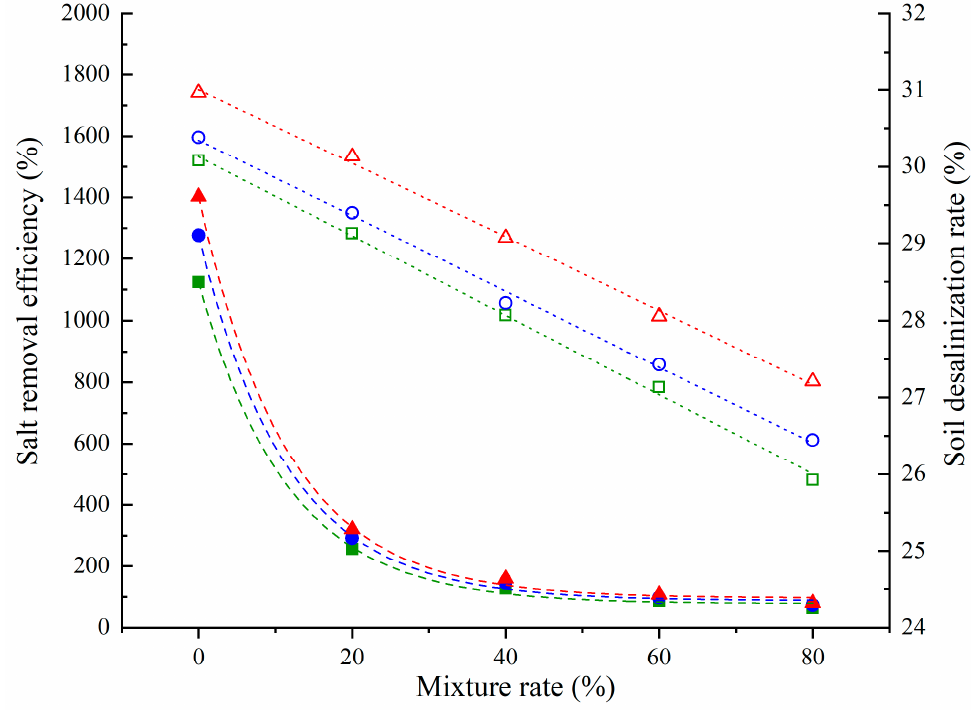
Figure 10. Relationships between mixture rate of leaching water and desalination indexes (salt removal e ffi ciency SRE and soil desalination rate SDR) under di ff erent leaching